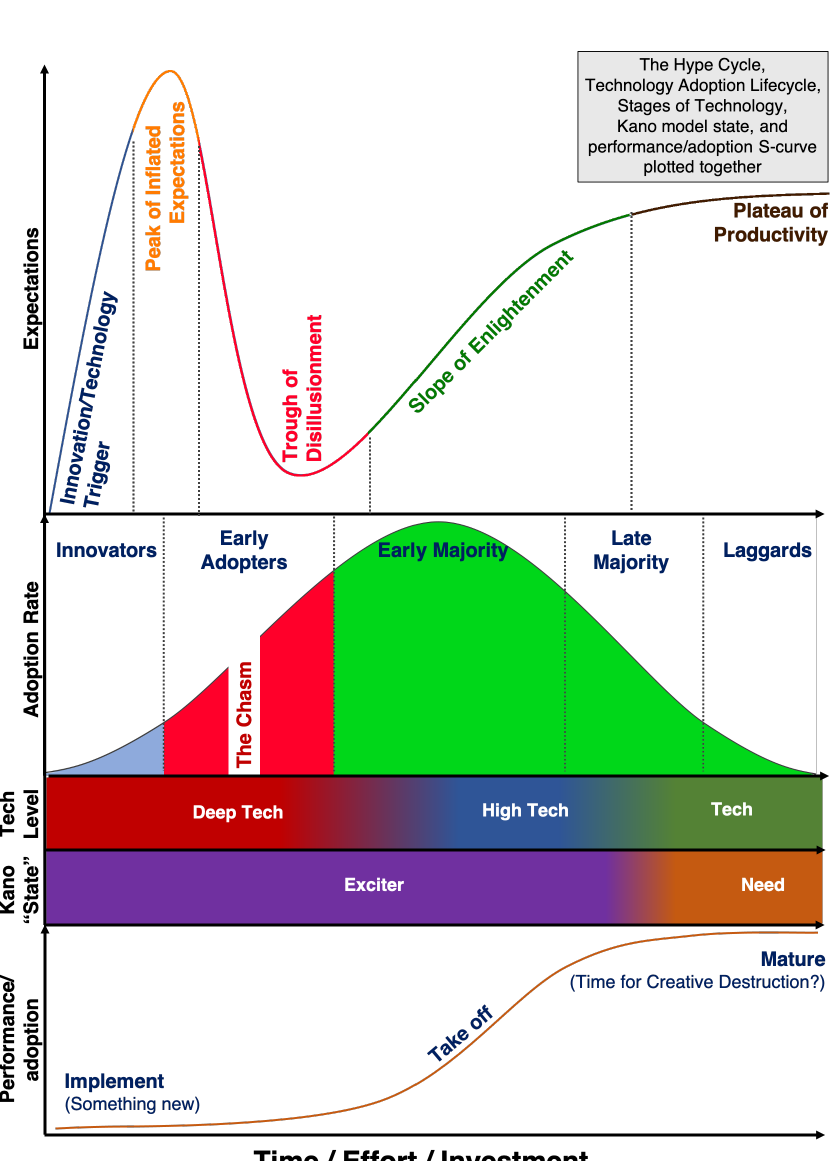
Fig. 1. Gartner’s Hype Cycle (top) shows one view of “typical” technology evolution, from in- novation trigger, through implementation challenges and discovery, to widespread